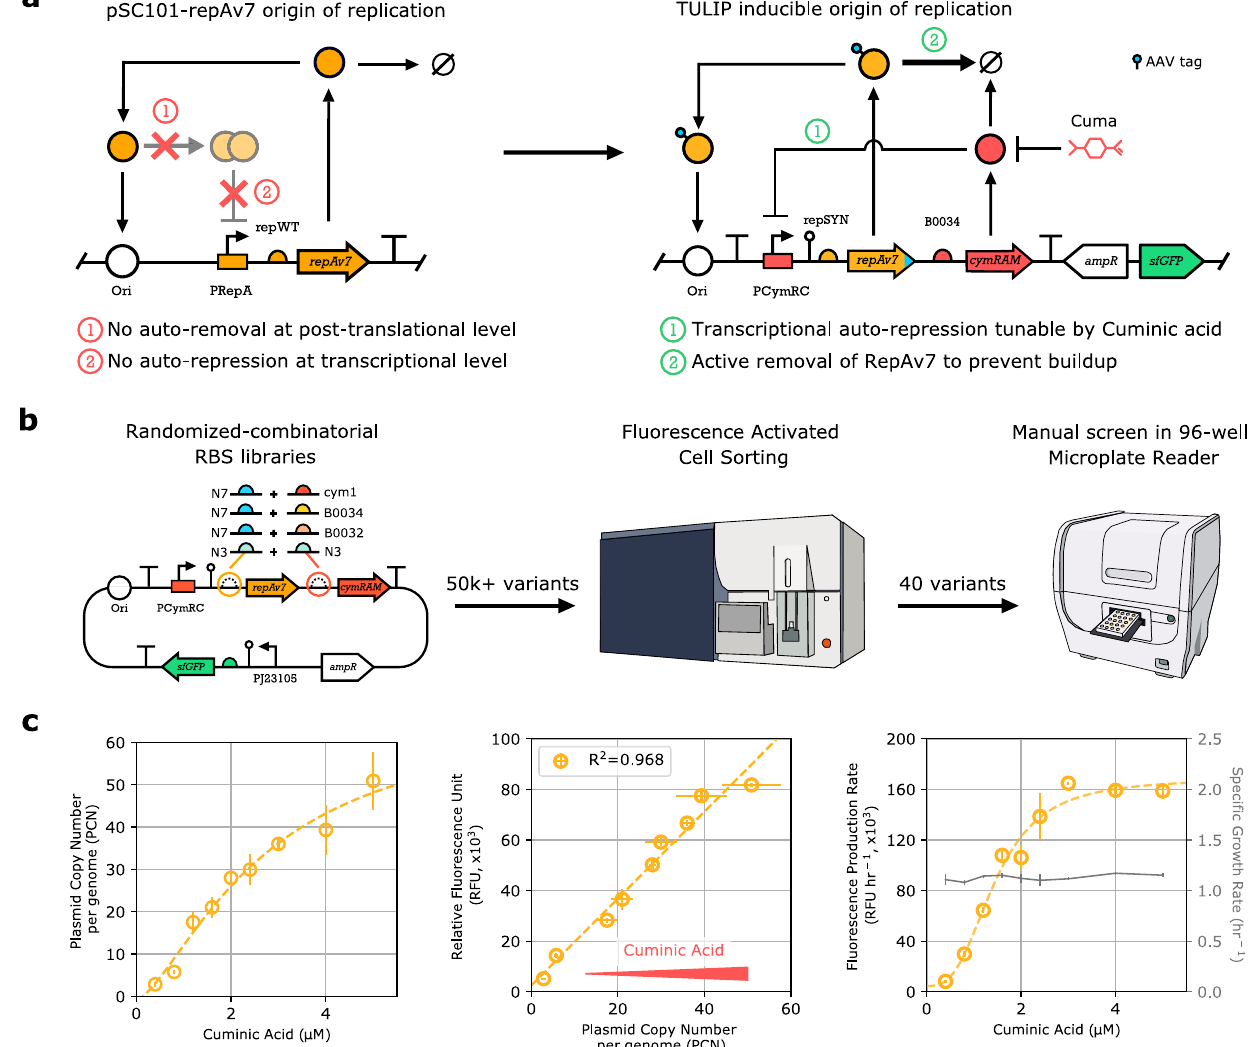
Fig.2|Design,constructionandscreeningofTULIP.a Linearplasmidmapofthe mutant pSC101-repAv7 origin and of the fi nal TULIP plasmid, illustrating the mechanism of PCN control. Upregulation of PCN is achieved via RepAv7, while negative feedbackisrealized viaCymRAMand can bemodulated viaCuminicacid. b Schematic visualization of the work fl ow for screening and selecting the fi nal TULIP variant, including library design, fl uorescent activated cell sorting, and